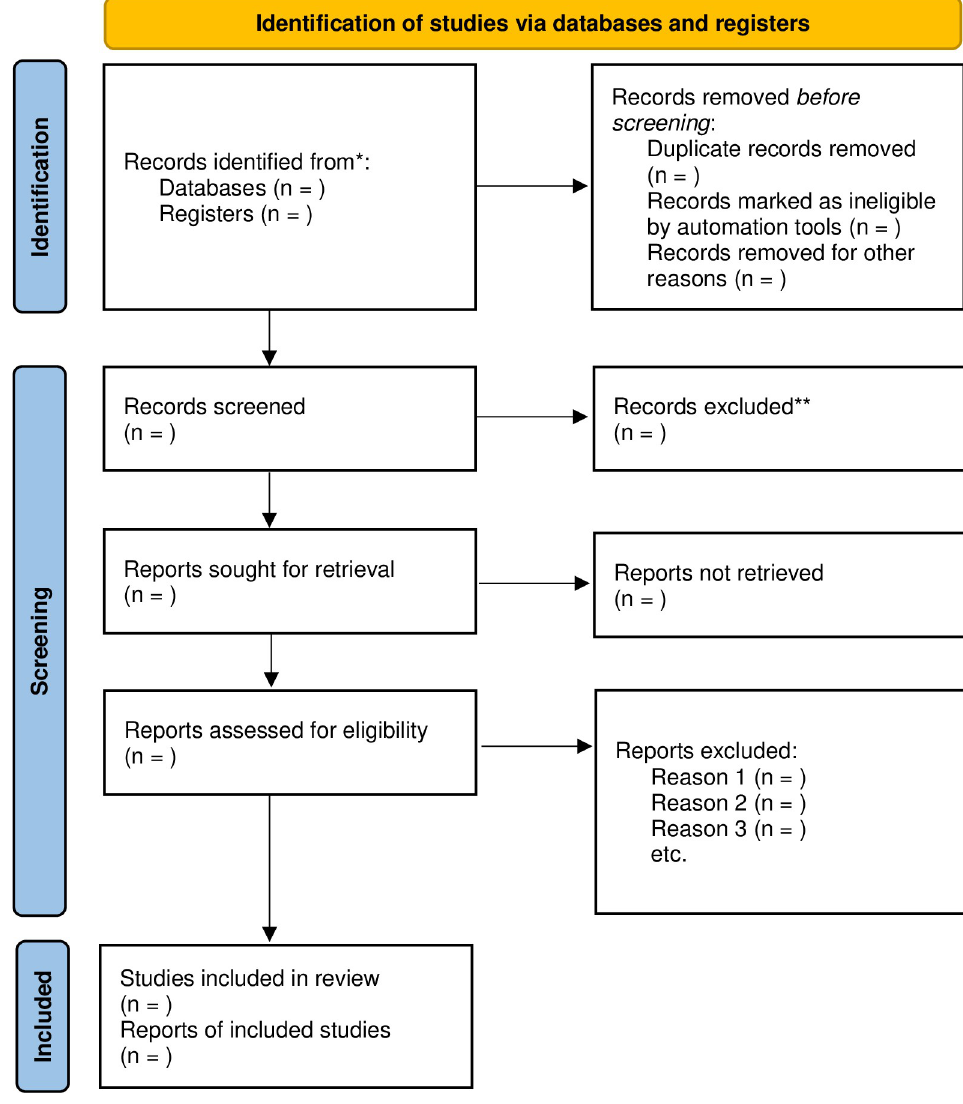
Fig 1. Flowchart of identification and screening for the eligible